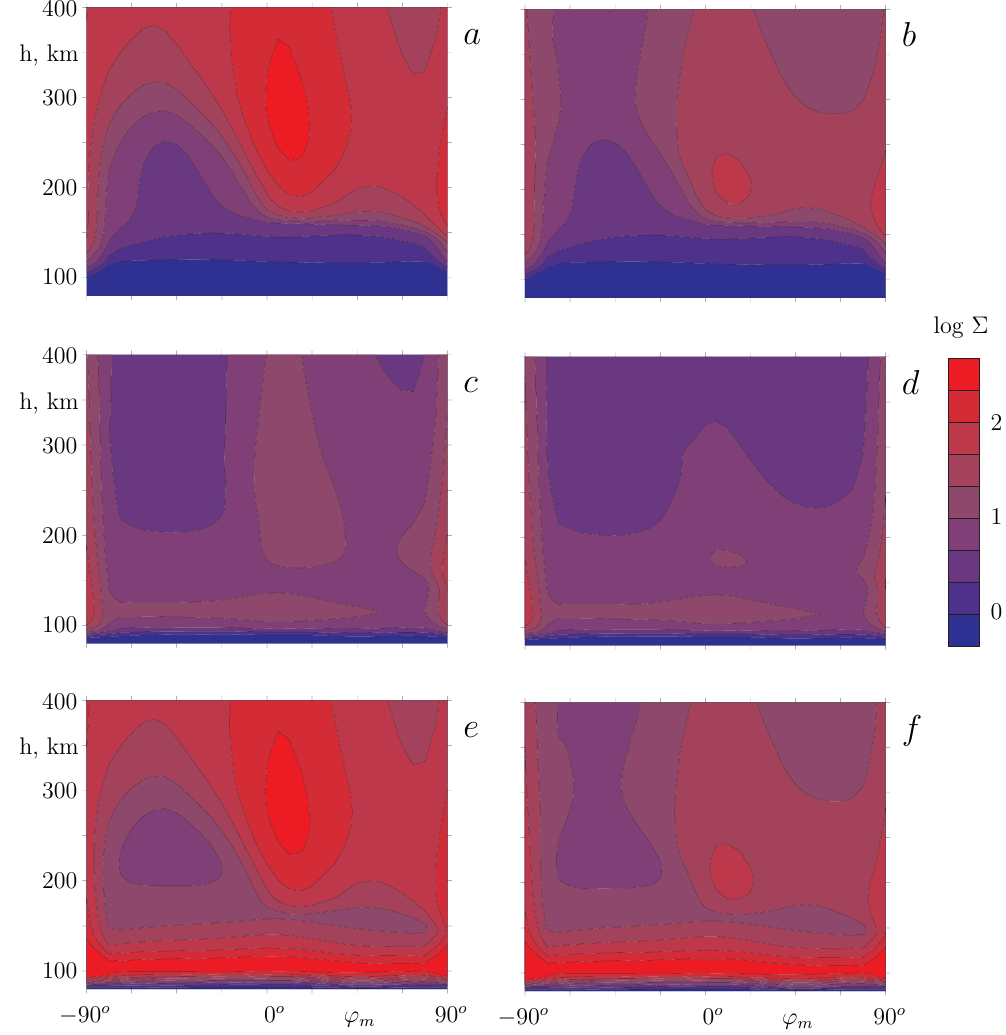
Fig. 7. Conductance distributions above the night half of the geomagnetic equator. Left panels show conductances for a short-term process. Right panels show conductances for a long-term process, for which modifications of the conductivities are done for t 0 = 3h. Panels (a) , (b) are for log 10 (6 P ) , panels (c) , (d) are for log 10 (6 H ) , panels (e) , (f) are for log 10 (6 C ) , where conductances in S units are used. The color scale is common for all panels. A common color is used for 6< 1 S and the contours 6< 1 S are not plotted.